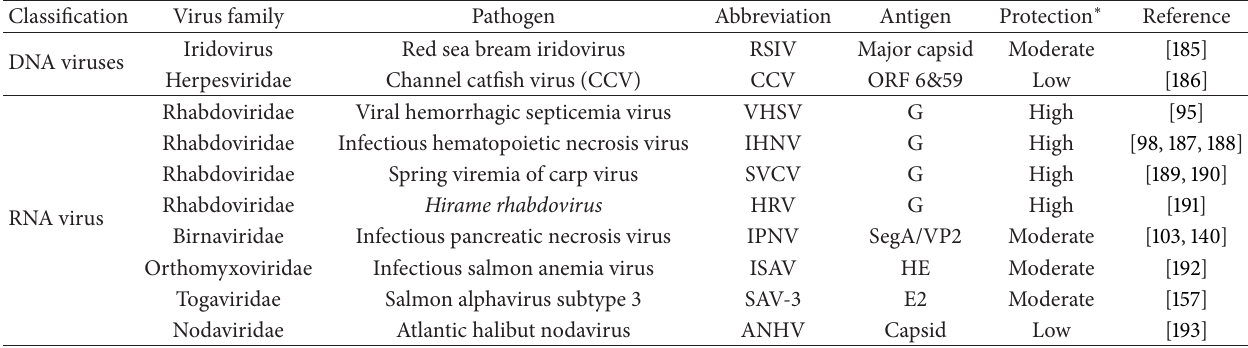
Table 3: DNA vaccines explored in